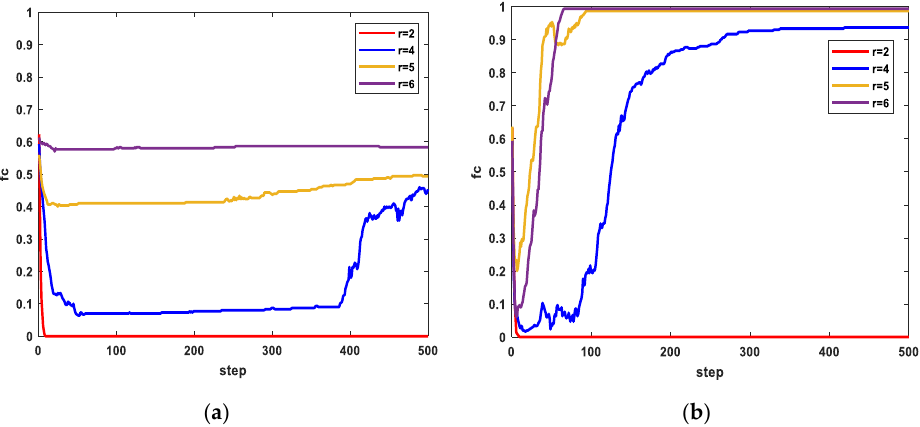
Figure 3. Evolutionary plots of system cooperation levels for different gain factors r, where ( a ) and ( b ) correspond to  = 0.01 and  = 0.1, respectively. respond to δ = 0.01 and δ = 0.1,